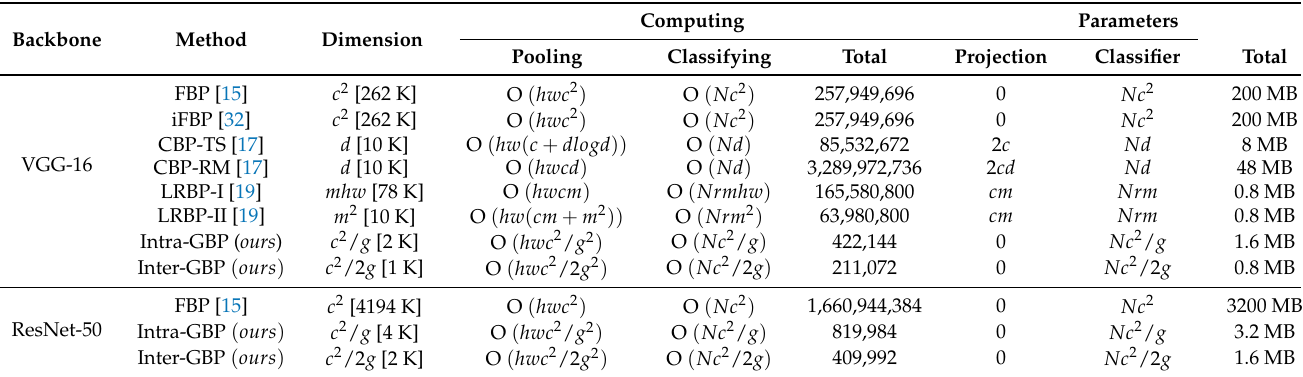
Table 3. Comparison of different compact bilinear pooling methods. We used VGG-16 and ResNet-50 as the backbone respectively to compare the computational complexity, representation dimensions and the parameters needed to be learned (excluding the backbone network).